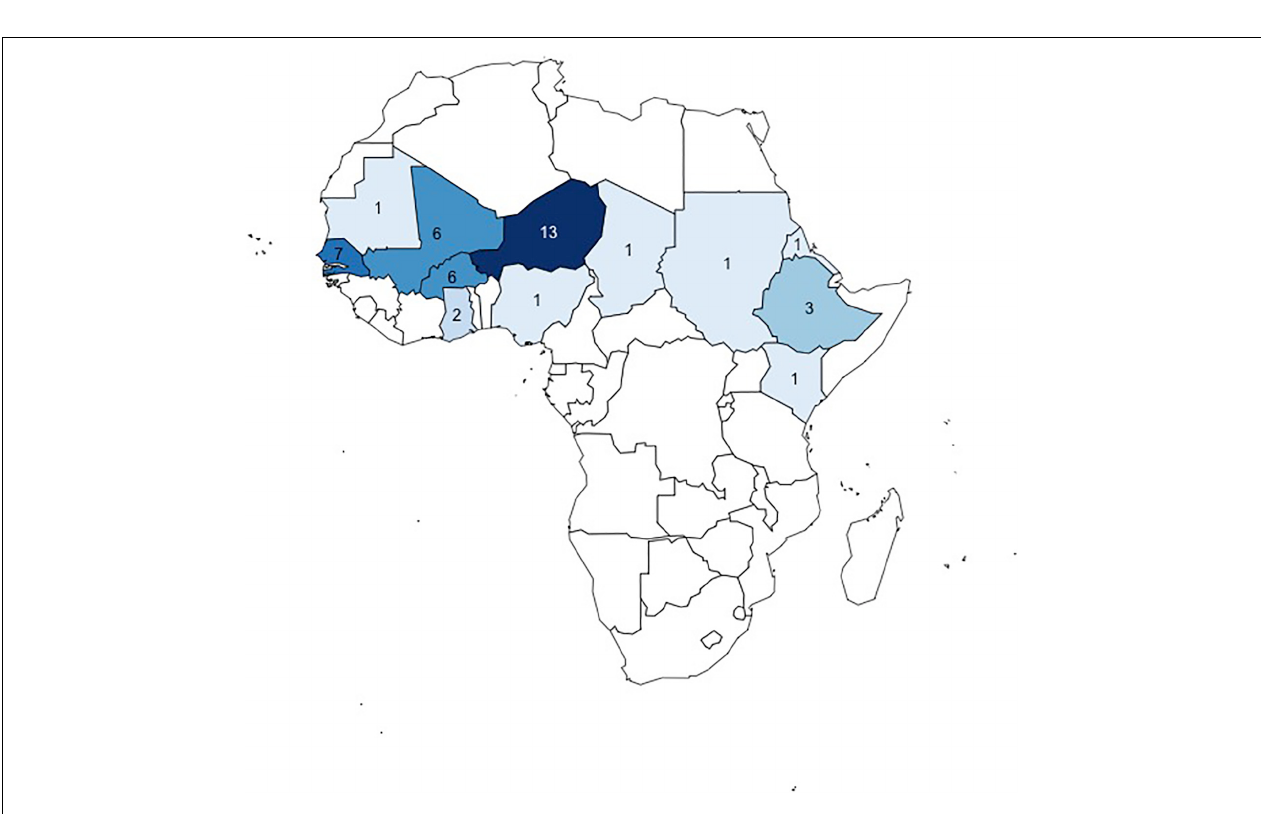
Frontiers in Forests and Global Change |